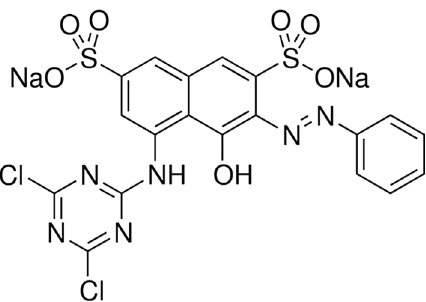
Fig. 1 Molecular structure of Procion Red